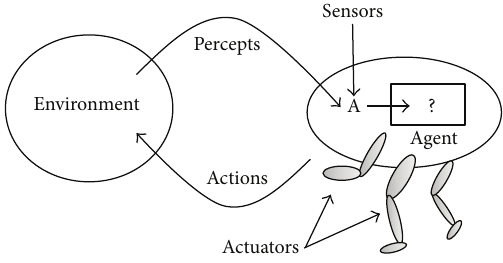
Figure 1: Agent-environment interaction